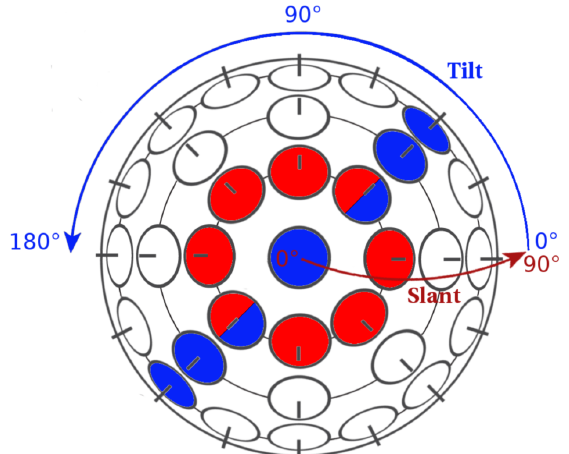
Fig. 8 Slant (red) and tilt (blue) components of surface orientation on a unit sphere. Red circles (including two bi-colors) represent an area with equal slant angels and blue circles (including two bi-colors) indicate an area with equal tilt angels on the